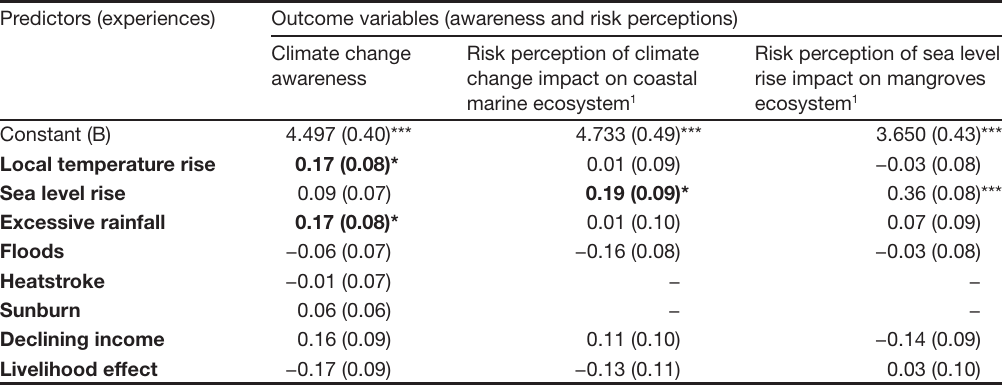
Table 2. Results of linear regression model exploring the association between participants’ personal experience and climate change awareness; personal experience and risk perception of climate change impacts in the coastal marine ecosystem in Palawan, Philippines (standard errors in